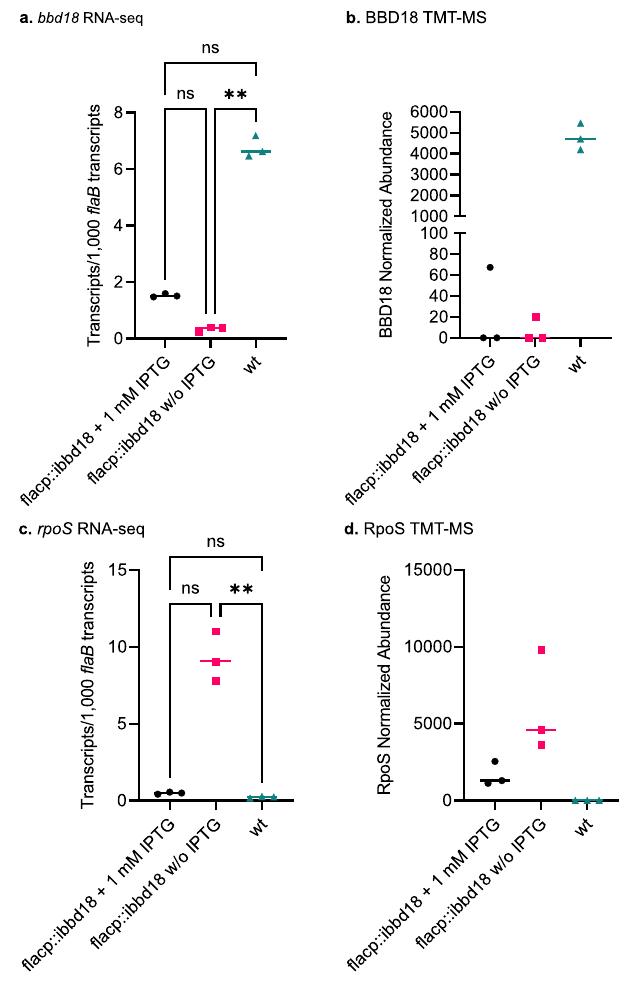
Fig.3|Expressionof bbd18 /BBD18and rpoS /RpoS. RNA-seq( a/c )andTMTmass- spec ( b/d ) of bbd18 /BBD18 and rpoS /RpoS. Values were normalized to fl aB /FlaB. Proteinlevelsmirrortranscriptlevels.Dataarepresentedinallgraphsasindividual values of biological replicates with the mean value indicated. Dunn ’ s multiple comparison of the Kruskal-Wallis test was used to determine signi fi cance. Three biological replicates of all three samples underwent TMT mass-spec analysis; however, RpoS was only detected in fl acp::ibbd18 cultures. n =3 biological repli- cates. * p value<0.05, ** p